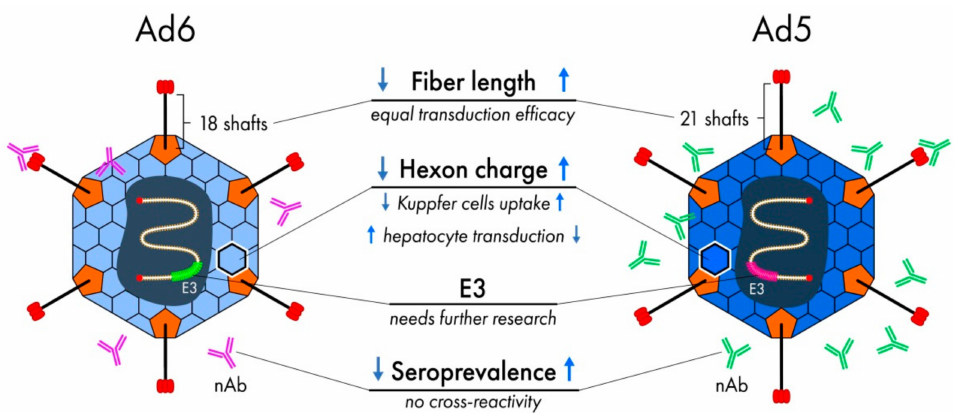
Figure 2. Major differences between Ad6 and Ad5. (1) The fiber protein of Ad6 has 18 shaft repeats in contrast to 21 repeats for Ad5. (2) Hexon charge of Ad6 is lesser than that of Ad5. (3) The Ad6 E3 region significantly differs from Ad5 E3. (4) Ad6 is less seroprevalent than Ad5, and there is no neutralizing antibodies (nAb) cross-reactivity between these two